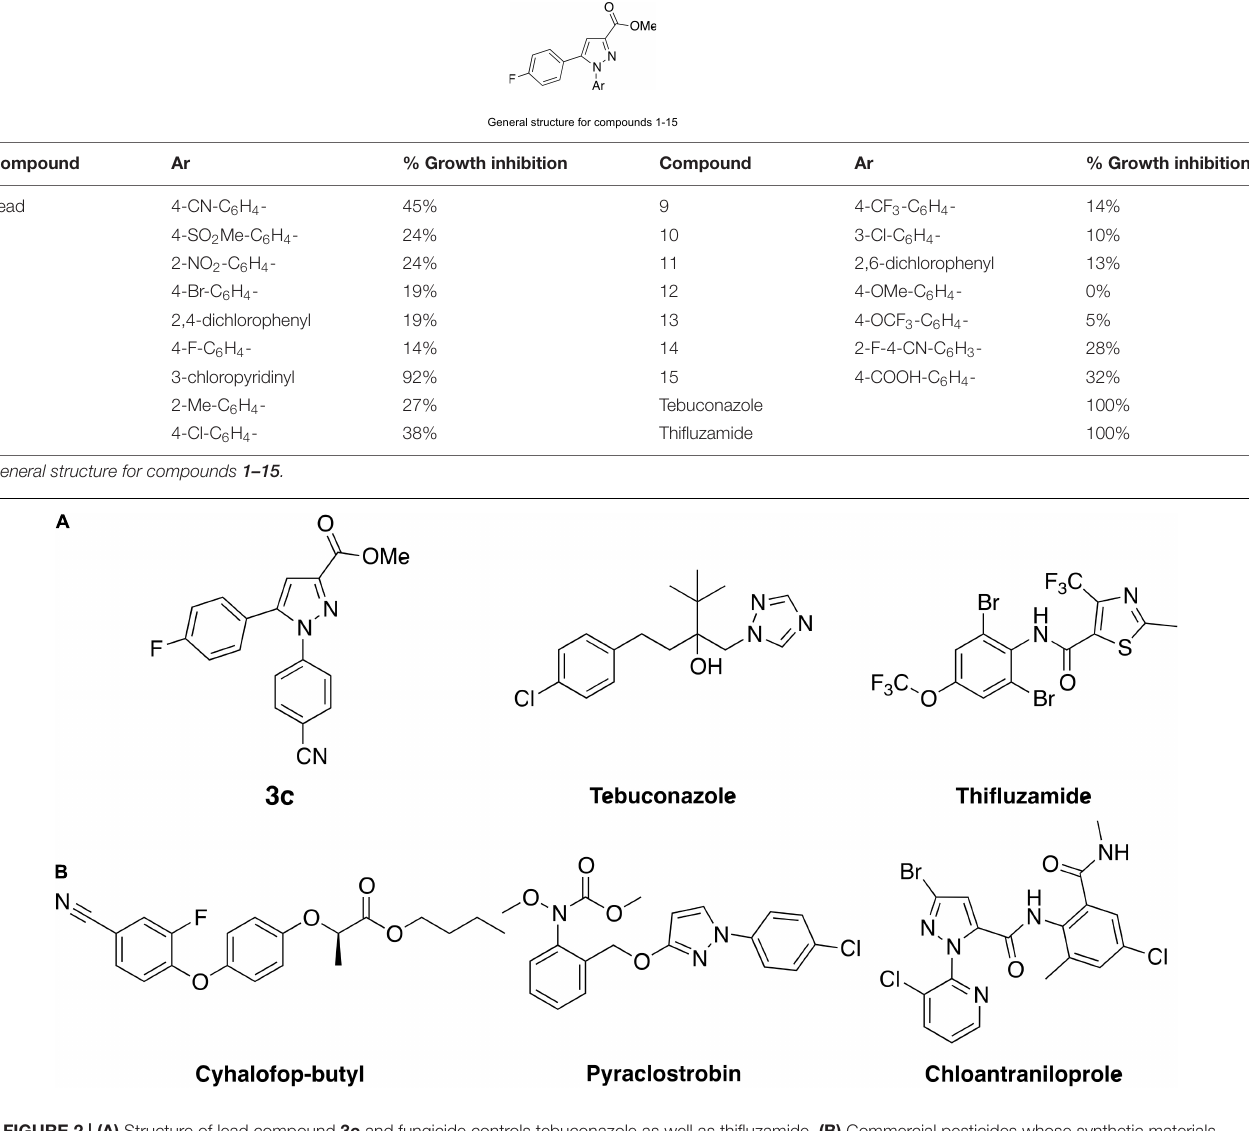
this series of compounds to the alteration of electronic